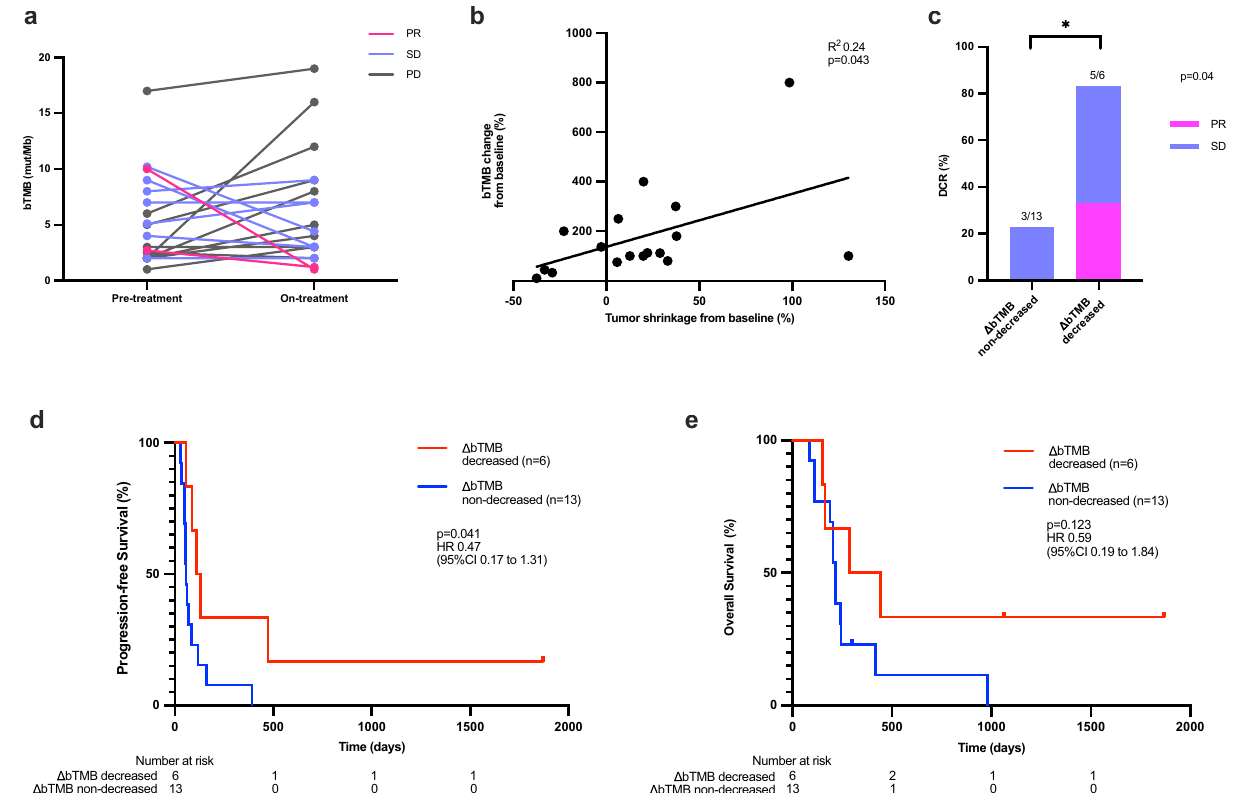
Figure 5. The association between ΔbTMB dynamics and clinical outcome of gastric cancer patients treated with nivolumab monotherapy. ( a ) Association between tumor response and changes of bTMB between pre- vs. on-treatment (immediately before the third cycle) samples. ( b ) Correlation between bTMB change from the baseline and degree of tumor shrinkage. ( c ) Comparison of disease control rate (DCR) between cases with decreased bTMB vs. non-decreased bTMB. Kaplan–Meier estimates of progression-free survival (PFS, d ) and overall survival (OS, e ) of patients with decreased- vs. non-decreased- bTMB. bTMB blood tumor mutation